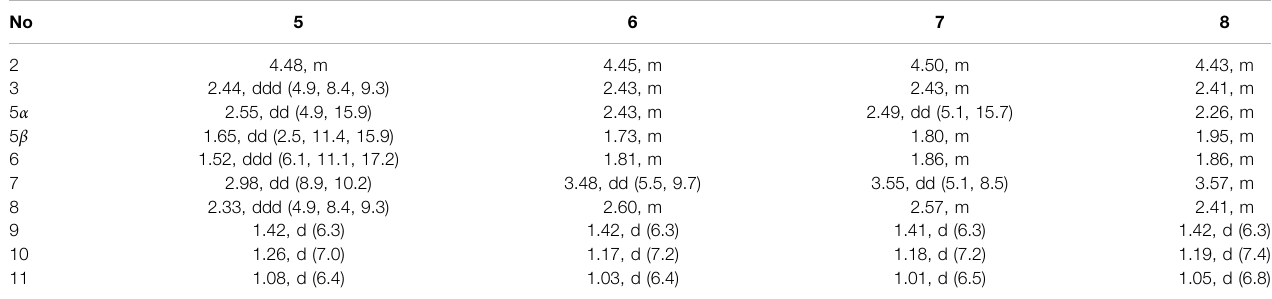
TABLE 3 | 1 H NMR (500 MHz) data for compounds 5 – 8 in CD 3 OD ( δ in ppm, J in Hz). a